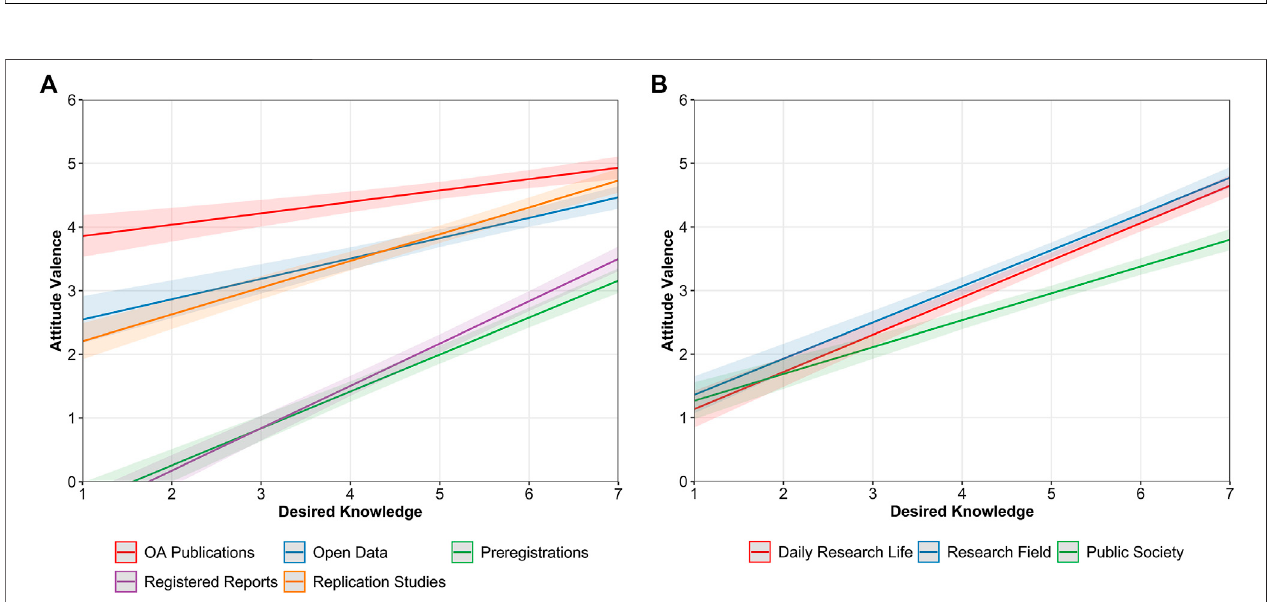
FIGURE 6 | Predicted values of attitude valence as a function of ECRs ’ desired knowledge across OS practices (A) and different perspectives (B) . Bandwidths represent 95% con fi dence intervals (CIs).